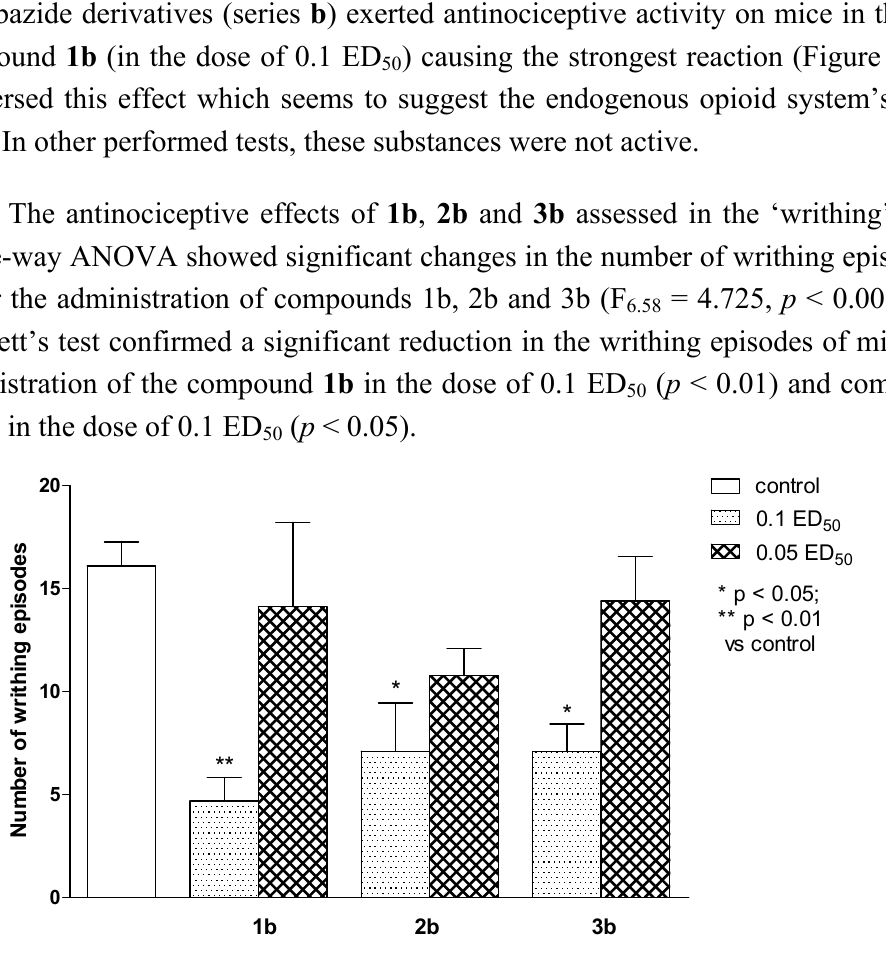
Figure 5. The influence of naloxone, 5 mg/kg, s.c. on antinociceptive activity of 1b , 2b and 3b evaluated in the “writhing” test. One-way ANOVA showed significant changes in the number of writhing episodes of mice after the administration of compounds 1b, 2b and 3b (F = 6.589, p < 0.0001). Post hoc Dunnett’s test confirmed a significant reduction in 6.67 the writhing episodes of mice after the administration of the compound 1b in the dose of ( p < 0.001), 2b in a dose of 0.1 ED ( p < 0.01) and 3b in a dose of 0.1 ED 0.1 ED 50 50 50 ( p < 0.05). Naloxone inhibited antinociceptive action of 1b ( p < 0.001 vs. compound 1b ; post hoc Dunnett’s